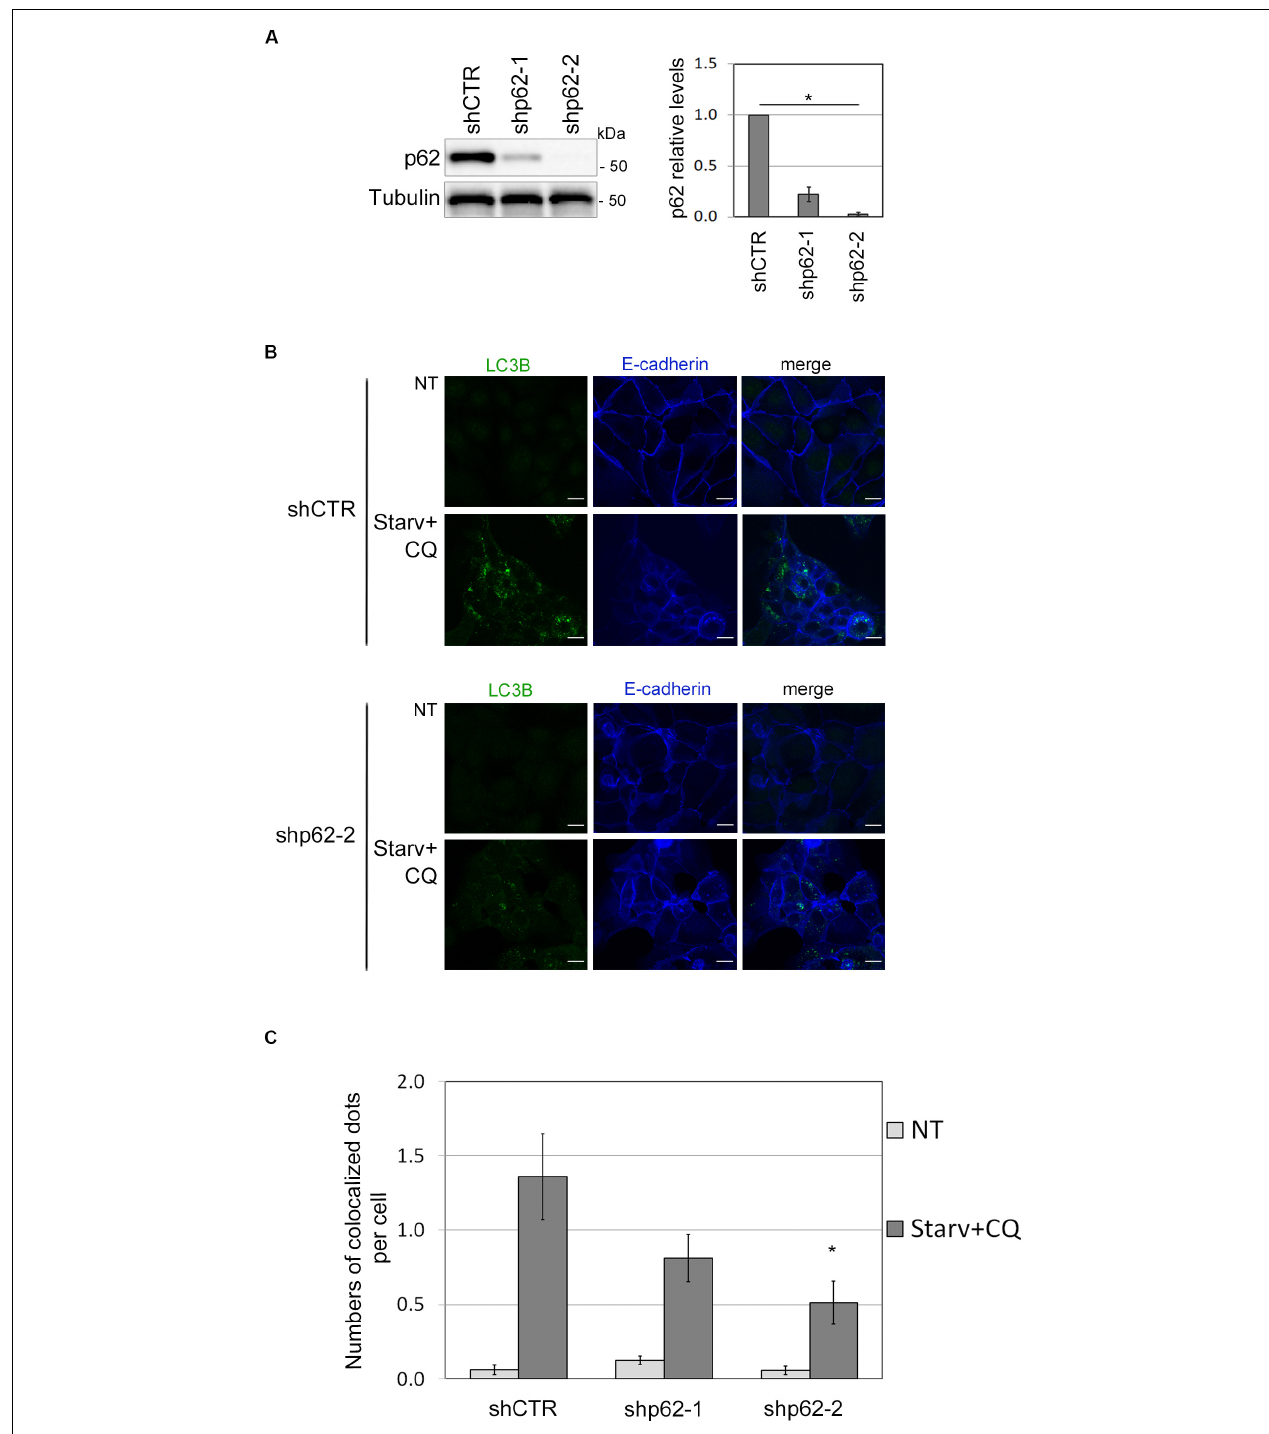
FIGURE 5 | SQSTM1/p62 knock-down restrains the E-cadherin delivery into autophagosomes. (A) Immunoblot showing the expression of SQSTM1/p62 in silenced (shp62-1, shp62-2) and in control (shCTR) HCC1937 cell line. The graph on the right reports the mean of SQSTM1/p62 relative levels of three experiments with SEM as error bars. SQSTM1/p62 relative levels were obtained by normalization over γ -tubulin (Tubulin, loading control) and rescaling to the control sample. The asterisk means statistical significance ( p < 0.001) in the ANOVA test. (B) Representative images of shp62-2 and shCTR HCC1937 cell models untreated (NT) or starved and treated with CQ (Starv+CQ) for 8 h showing the E-cadherin and LC3B molecules stained with anti-E-cadherin/Alexa Fluor 633 and anti-LC3B/Alexa Fluor 488 antibodies, respectively. Merge images are reported. Scale bar, 20 µ m. (C) Graph reported the quantification of LC3B and E-cadherin colocalized dots per cell in the experiments carried out as in (B) . At least 100 cells per sample were measured in three independent experiments. Bars show SEM. * p < 0.05.